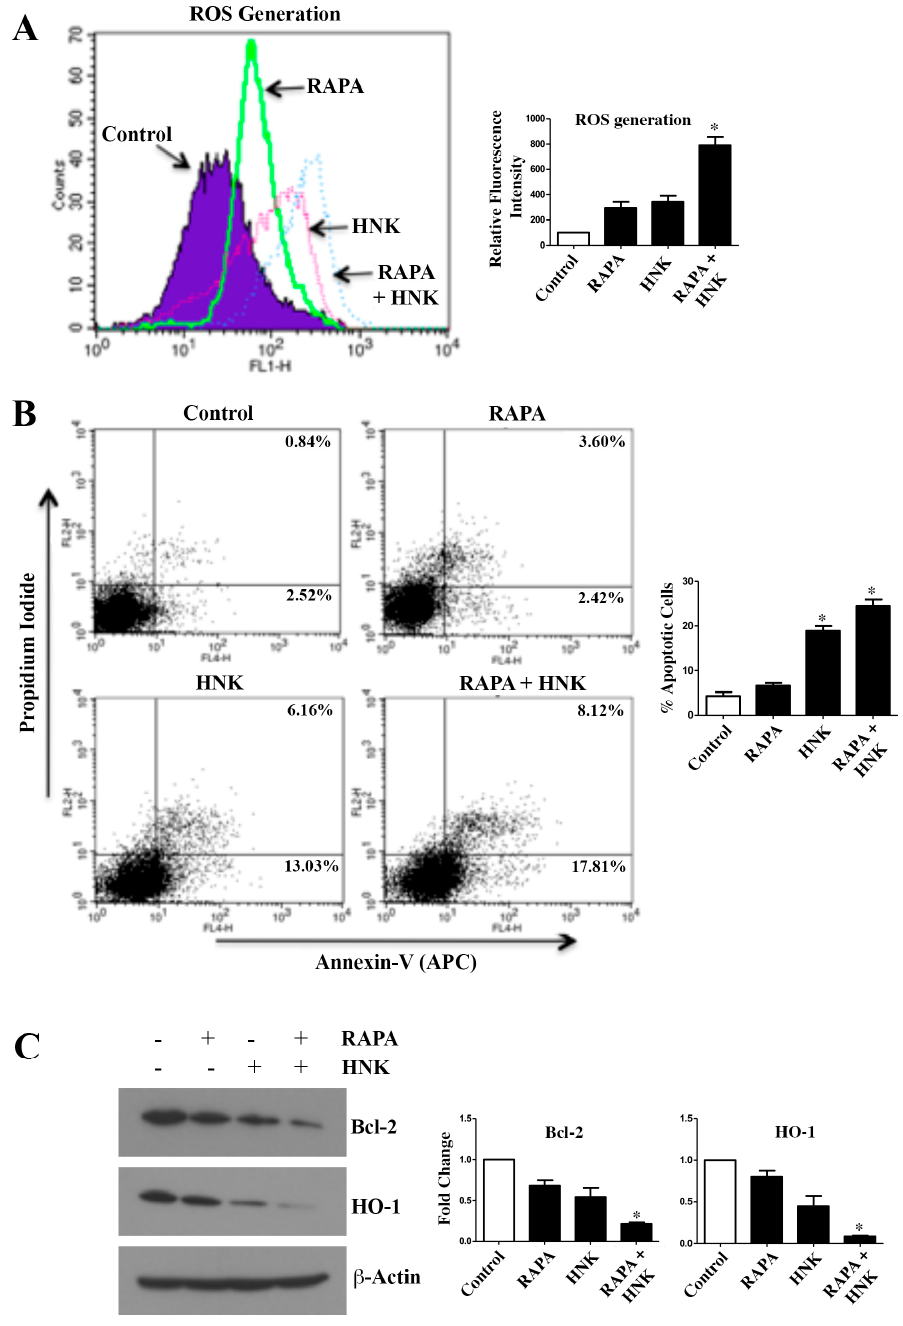
Figure 3. Honokiol (HNK) + Rapamycin (RAPA) combination markedly induces ROS generation and promotes renal cancer cell apoptosis. ( A ) 786 ‐ 0 cells were treated with RAPA (15 μ M) and Honokiol (40 μ M) either alone or in combination for 6 h. Following treatment, cells were stained with 2 ′ ,7 ′‐ dichlorofluorescein diacetate ‐ based total ROS detection agent and cellular ROS levels were assessed by flow cytometry. ( B ) 786 ‐ 0 cells were treated with RAPA (15 μ M) and Honokiol (40 μ M) either alone or in combination for 48 h. Following treatment, cells were stained with annexin V (APC) and propidium iodide and the apoptotic indices were analyzed by flow cytometry. ( C ) 786 ‐ 0 cells